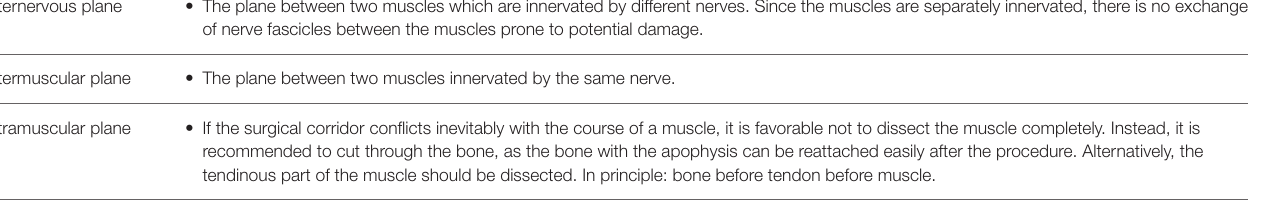
TABLE 1 | Surgical planes.